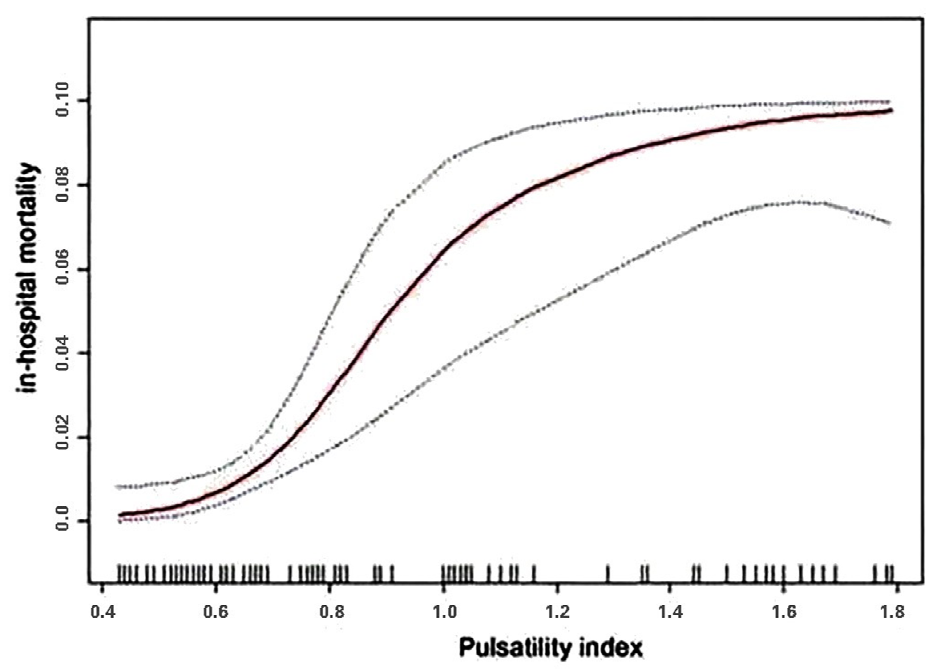
Figure 2. Association between PI and in-hospital mortality. The solid red line represents the smooth curve fit between the variables. Blue dots indicate the 95% confidence bands of the fit. The model was adjusted for age, gender, diabetes, hypertension, PLR, GCS on admission, blood transfusion volume, PTCI, DC, use of ventilator, shock, hemoglobin count, Na + concentration, traumatic coagulopathy, sedation, and analgesia. Table 4. Univariate analysis for PI using different models. Inflection Point of PI